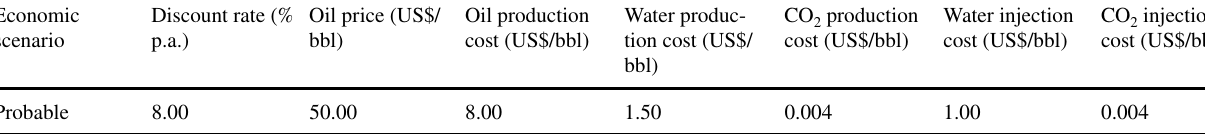
Table 6 Economic data for a probable economic scenario Economic